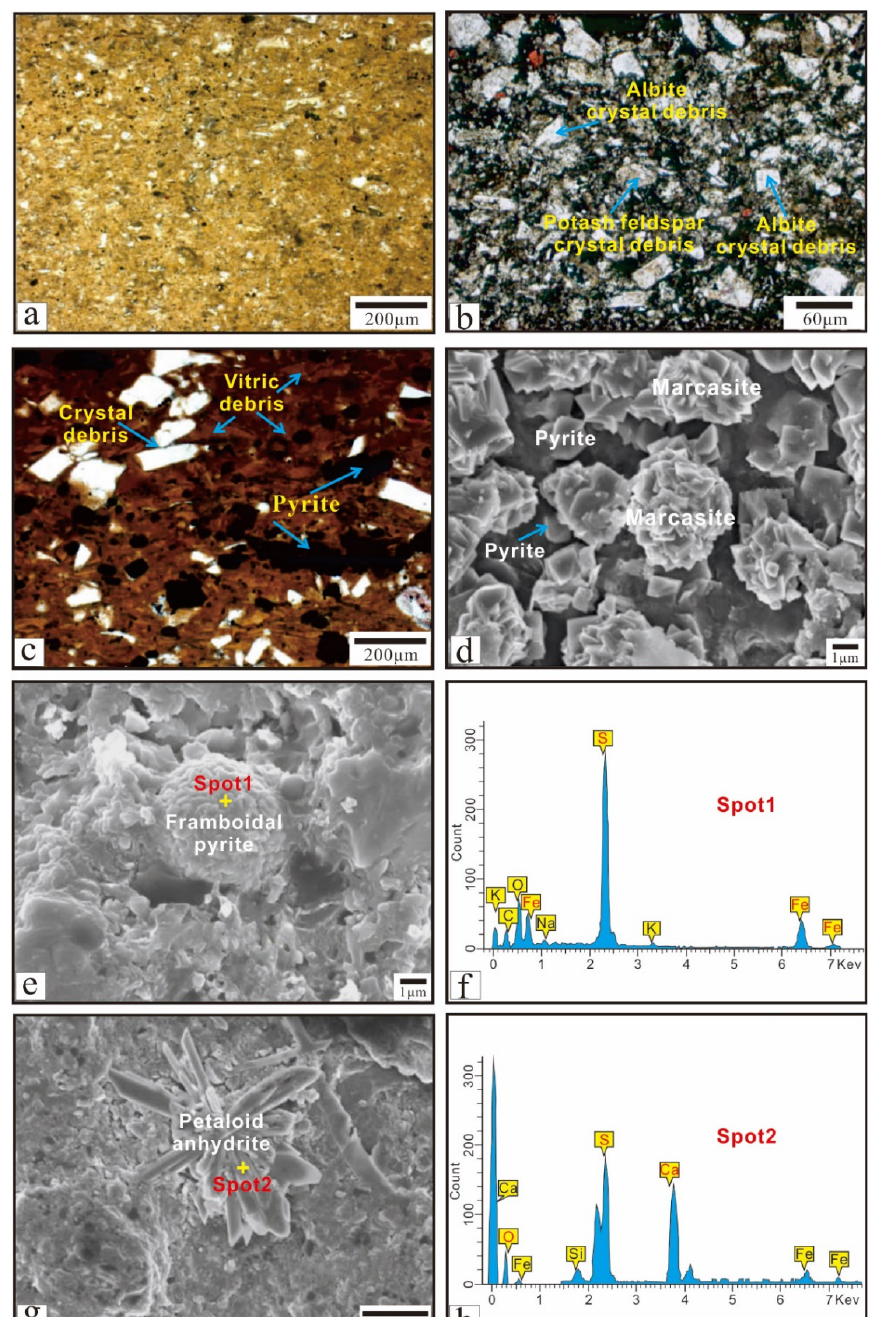
Figure 3 . The thin section images of volcanic tuff and SEM images and EDS data from Chang 7 shale: ( a ) the thin section image of ash tuff under plane polarized light (PPL) in outcrop sample H3 (Chang 7 2 ); ( b ) the thin section image of crystal debris tuff under cross-polarized light (XPL) in outcrop sample H9 (Chang 7 3 ); ( c ) the thin section image of vitric-crystal debris tuff under plane polarized light (PPL) in outcrop sample H12 (Chang 7 3 ); ( d ) the SEM image showing subglobular marcasite and ortho-octahedral pyrite of Well Z71 (Chang 7 3 , 1651.4 m); ( e ) the SEM image showing framboi- dal pyrite of Well Z59 (Chang 7 3 , 1263.2 m); ( f ) The EDS data of pyrite of Well Z59 (Chang 7 3 , 1263.2 m); ( g ) the SEM image showing petaloid anhydrite of Well Z40 (Chang 7 3 , 1475.0 m); ( h ) the EDS data of anhydrite of Well Z40 (Chang 7 3 , 1475.0 m).